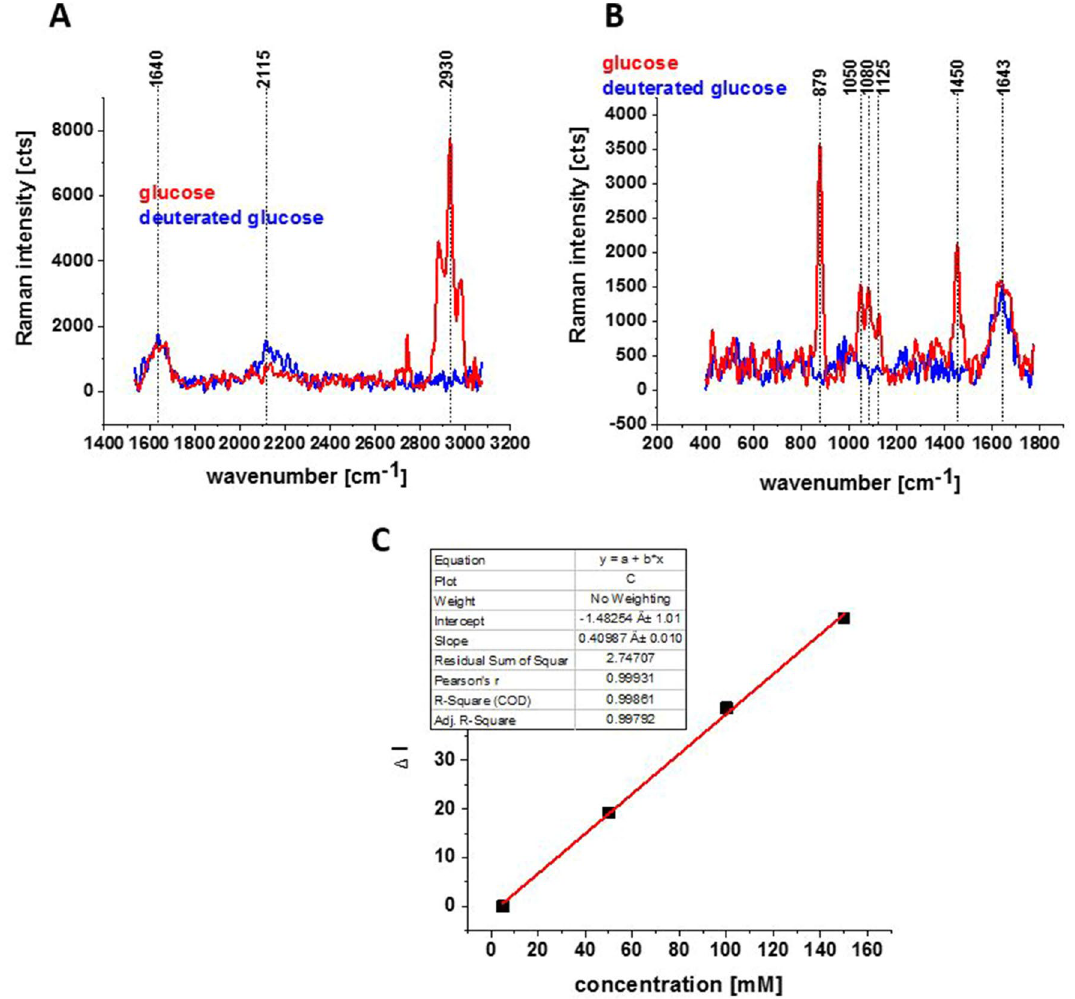
Figure 3. Raman spectra for glucose and deuterated glucose d- 7 (150 mM) in PBS in high frequency region ( A ) and in low frequency region ( B ); integration time 20 s, 1 accumulation, laser power 10 mW; Linear dependence (of Raman intensity of the band at 2120 cm −1 -background) on glucose d-7 concentration; integration time 1 s, 10 accumulation, laser power 10 mW ( C ), ΔI = I − I 0 , where I 0 is the intensity of the